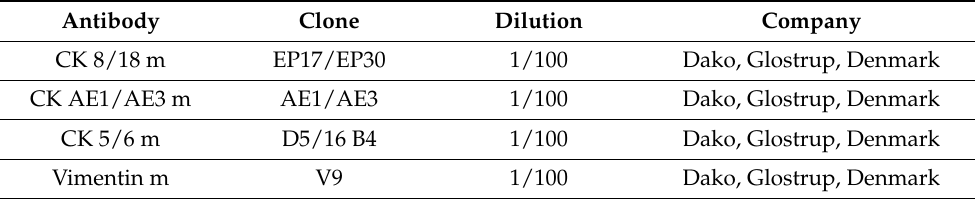
Table 1. The immunohistochemical markers used.